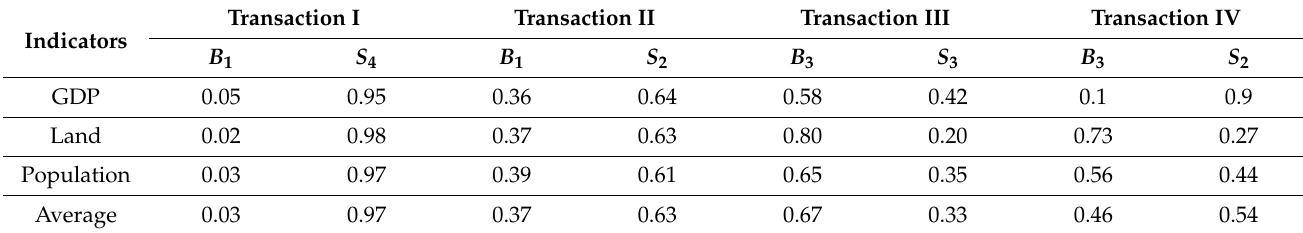
Table 4. Calculation results of unfair pullback